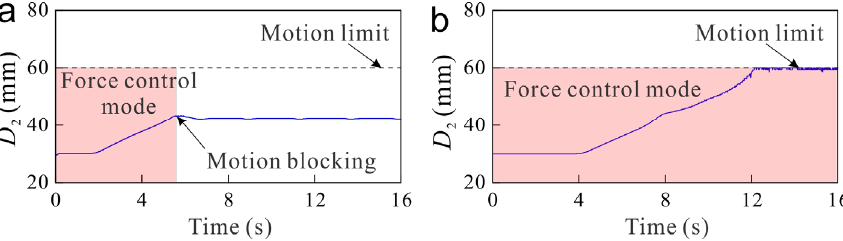
Figure 8. Blocking phenomenon during the force control process. ( a ) Blocking phenomenon due to the different sensor nonlinearity distribution characteristic; ( b ) blocking phenomenon avoidance by sensor nonlinearity distribution characteristic calibration.